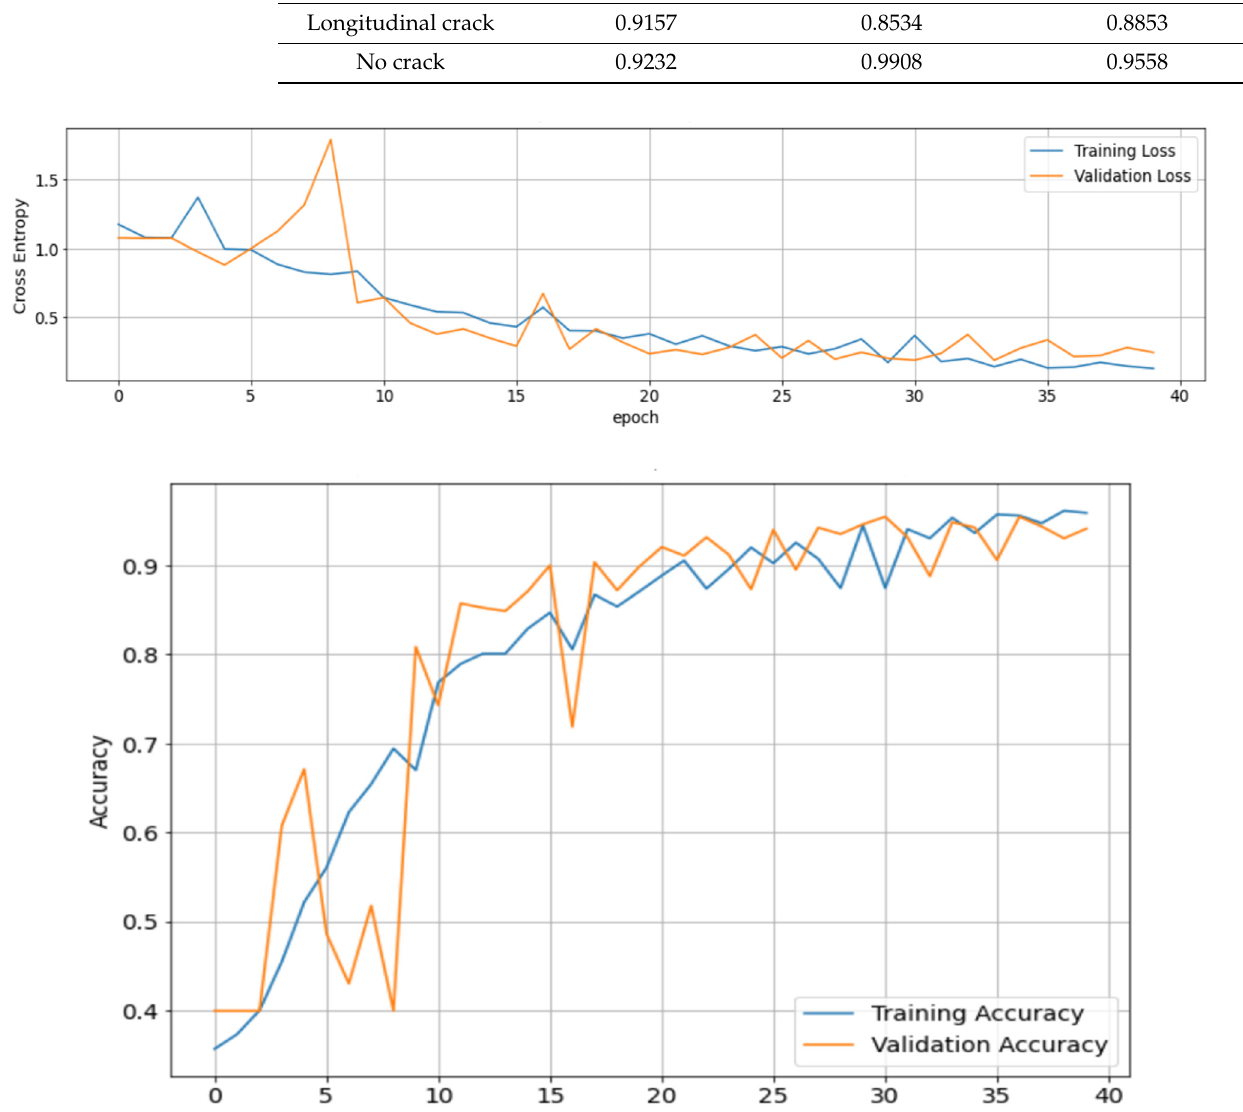
Figure 5. Training and validation plots of the proposed CNN model: loss graph ( top ) and accuracy graph ( bottom ).